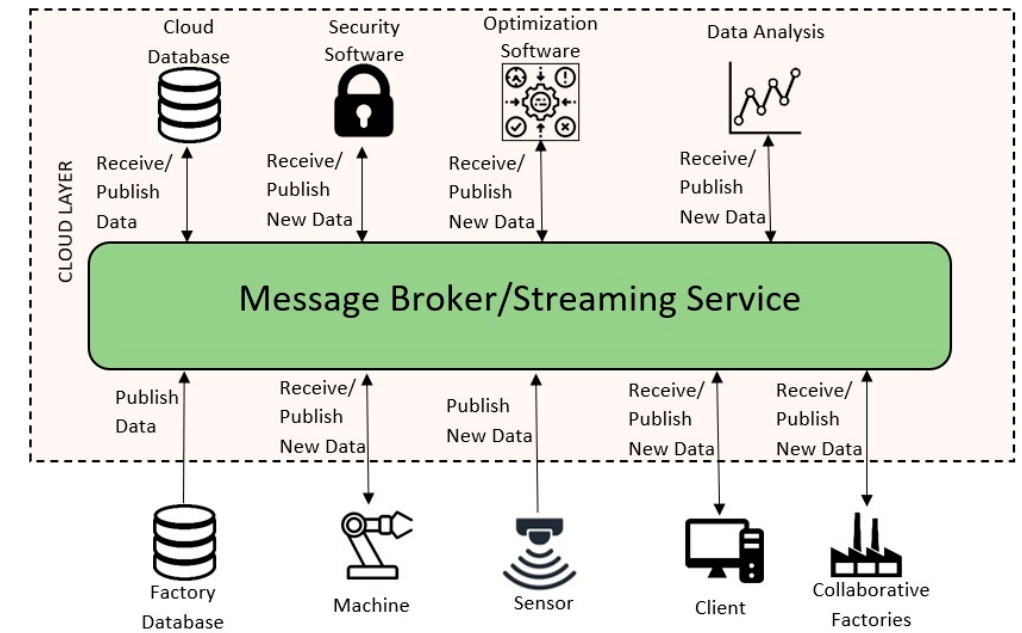
Figure 1. System Architecture.